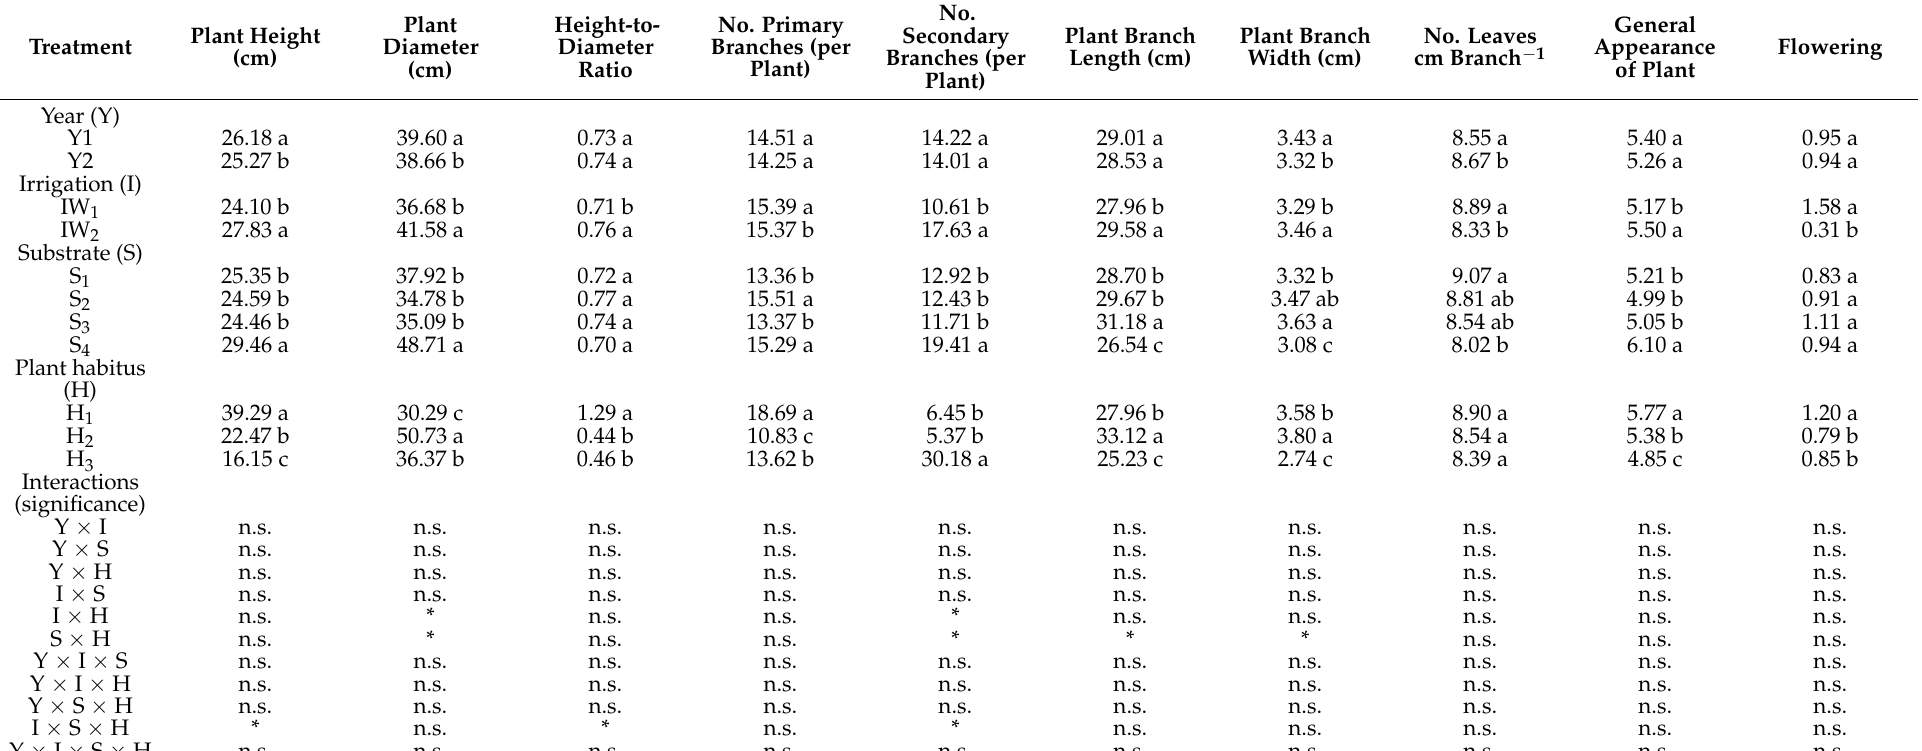
Table 2. Morphological and aesthetic characteristics of rosemary plants in response to year, irrigation, peat-alternative substrate and plant habitus.